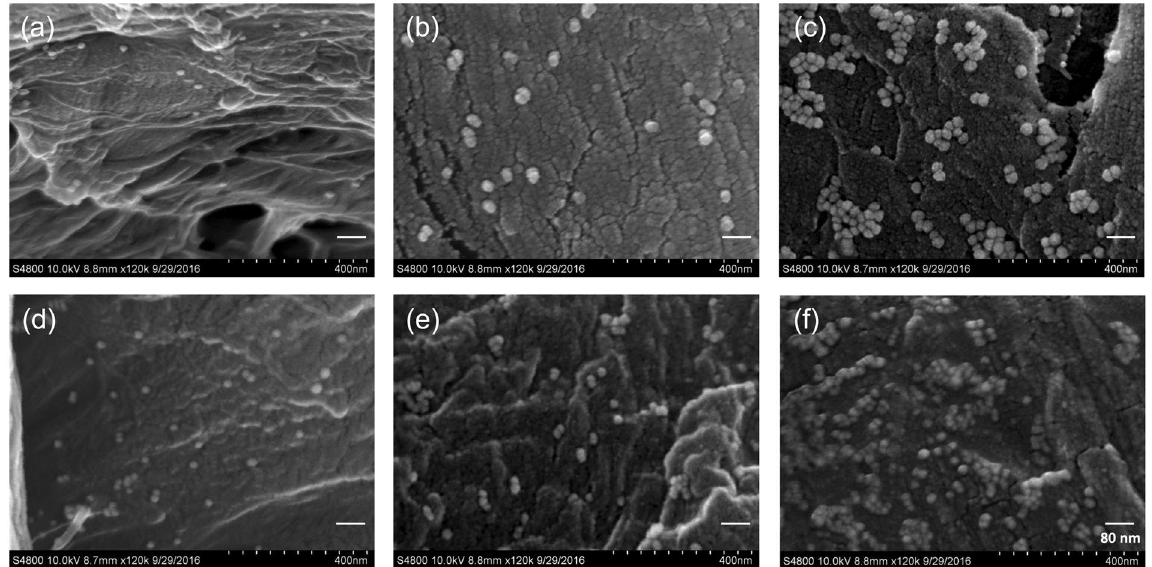
Figure 3. SEM images of the different Au and Au-Ag NPs on cellulose paper. The bright spots in the images are NPs, specifically ( a ) 20 nm Au NPs, ( b ) 20 nm Au-Ag 1000/1 NPs, ( c ) 20 nm Au-Ag 100/1 NPs, ( d ) 15 nm Au NPs, ( e )